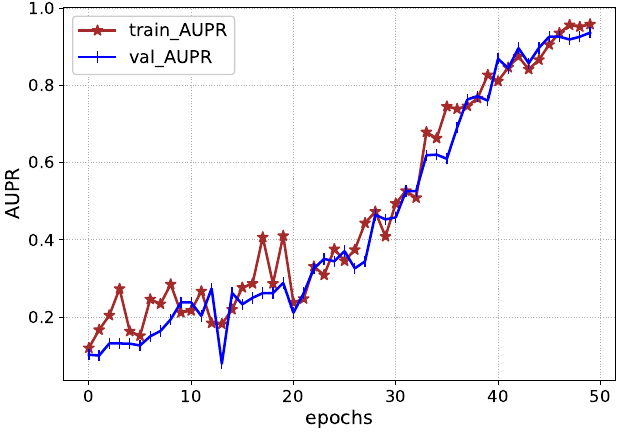
Figure 11. AUC during the training ResNet101-V2.